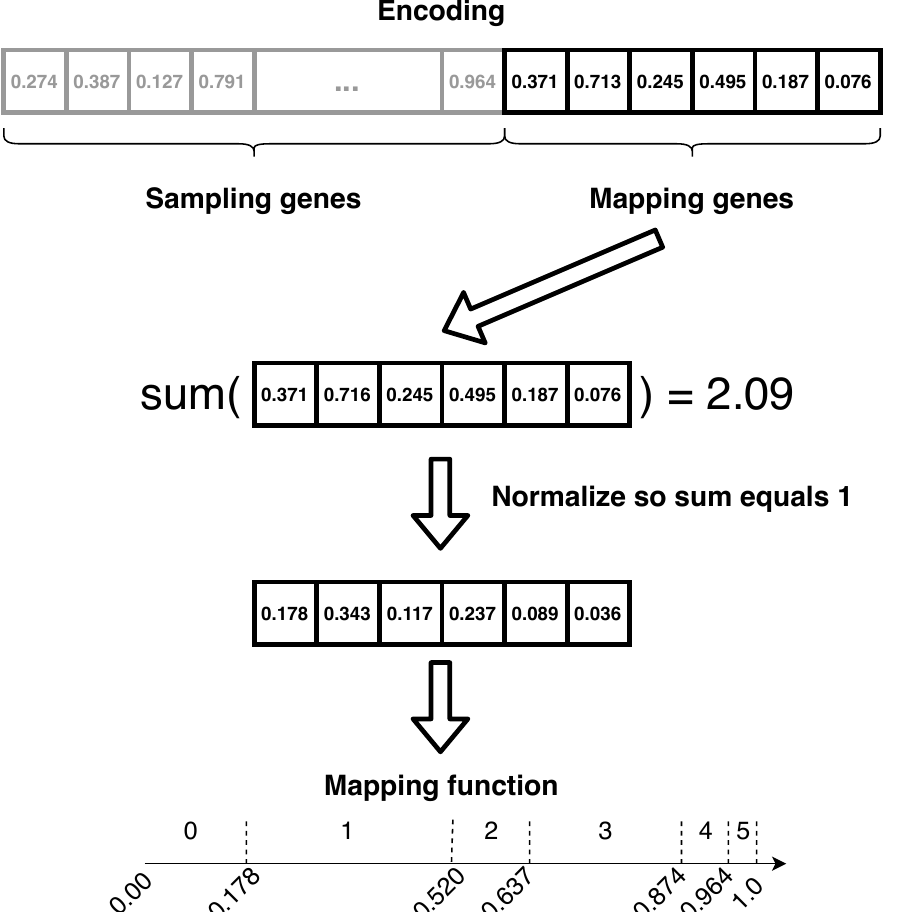
Figure 2. The self-adaptation with mapping genes in the encoding for data sampling task. The mapping values presented in this example are determined by the genotype and are not fixed, but adapt during the evolution